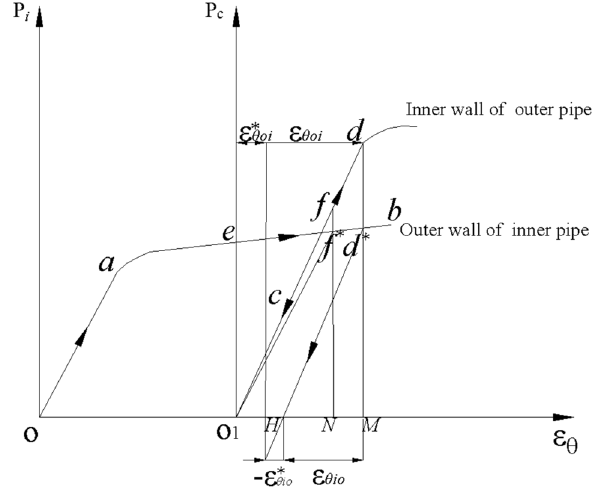
Fig. 2 The spinning forming principle of bimetal composite